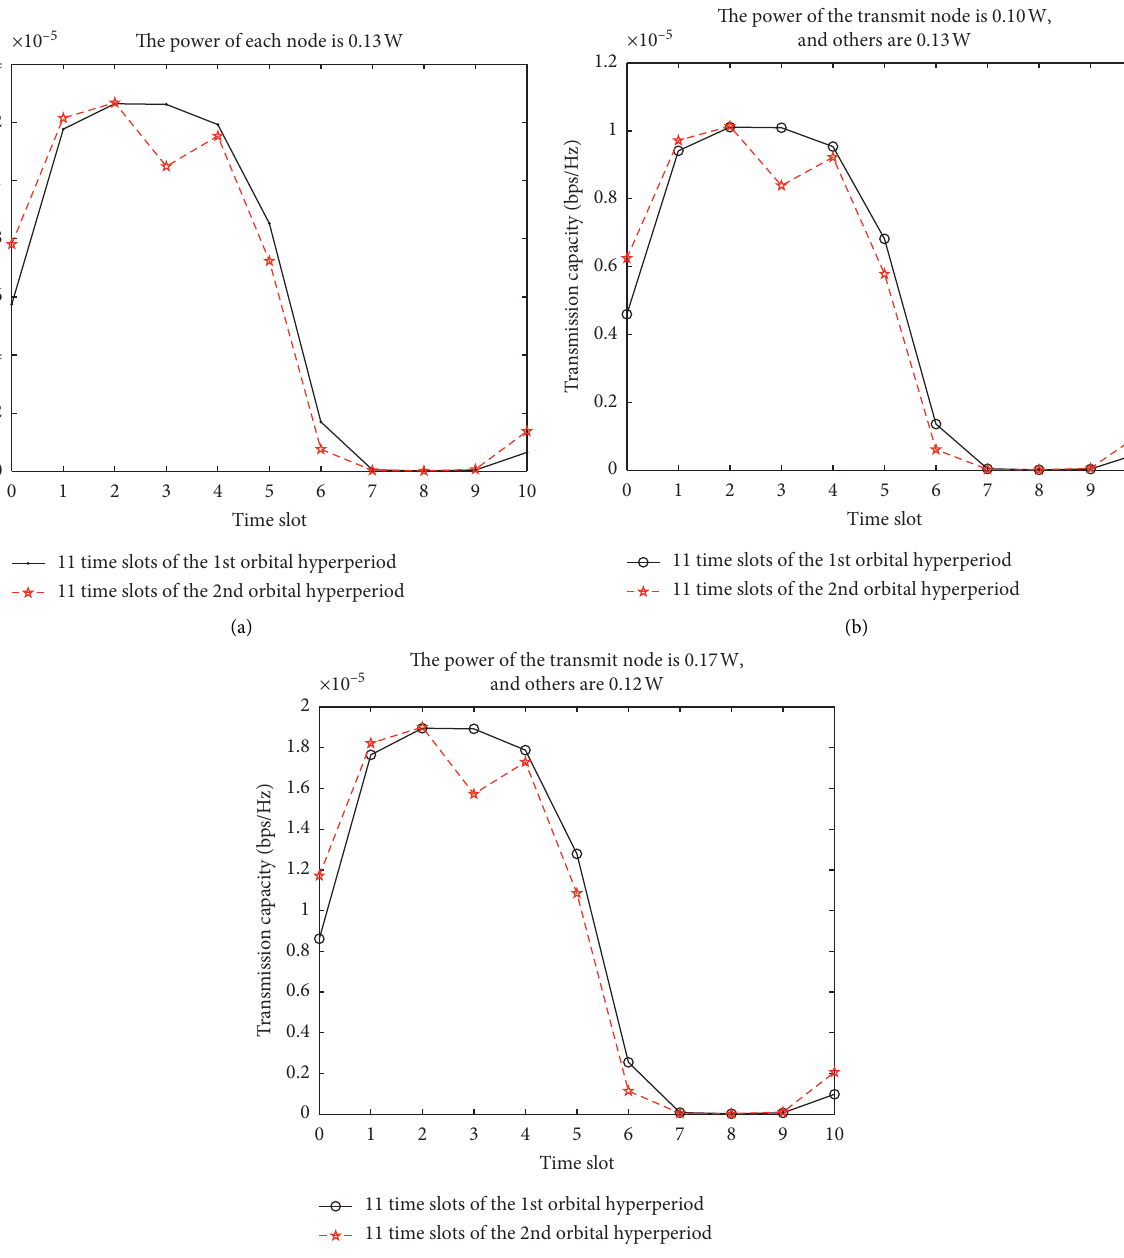
Figure 5: Time evolution characteristic of transmission